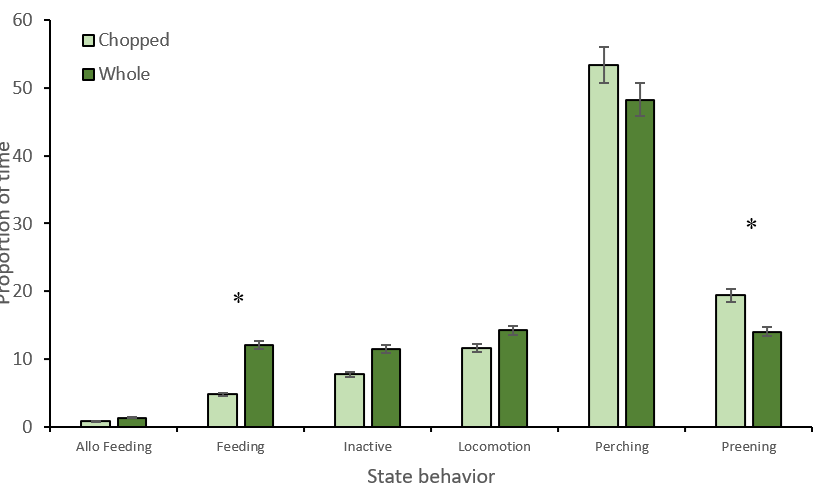
Figure 2. Activity budget for Fischer’s Turaco when provided with either chopped or whole-food items (+/ − standard error). * indicates a significant difference ( p < 0.05).